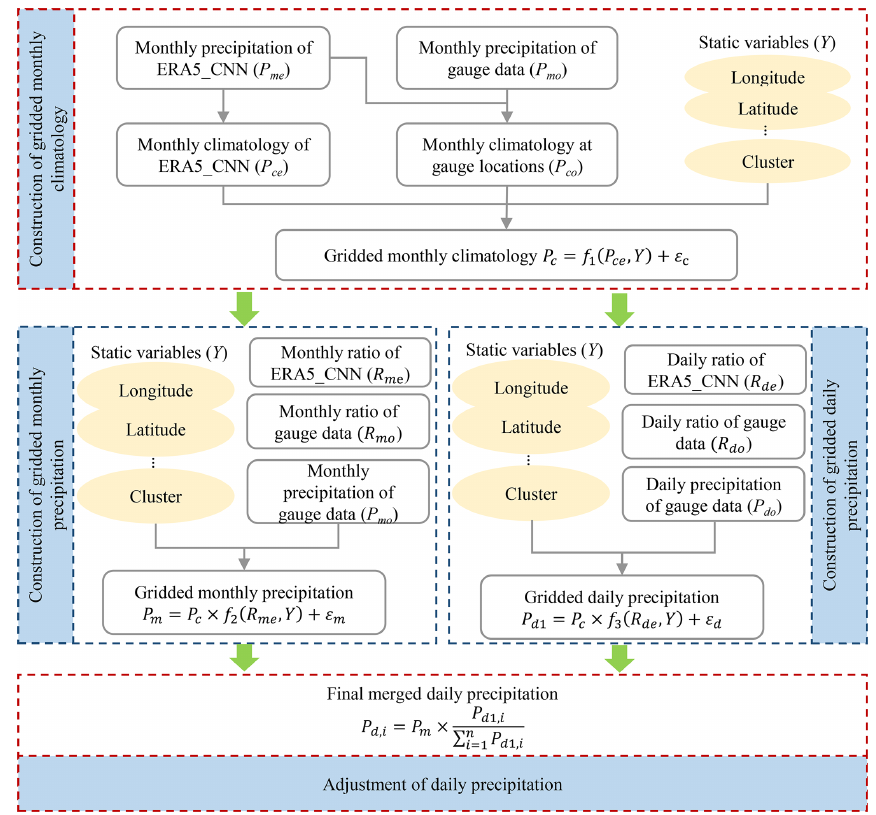
Figure 2. General flowchart of the merging algorithm. The static variables include the longitude, latitude, elevation, standard deviation of elevation and identifier of the clusters with different precipitation characteristics. The subscript “o” represents observation, “e” represents ERA5_CNN, “c” represents climatology, “m” represents monthly, “d” represents daily, “n” represents the number of days in a month and “i” represents the i th day in a month. f 1 , f 2 and f 3 denote the regression models based on random forest. ε c , ε m and ε d represent the residuals of estimations from RF, which are interpolated using the kriging